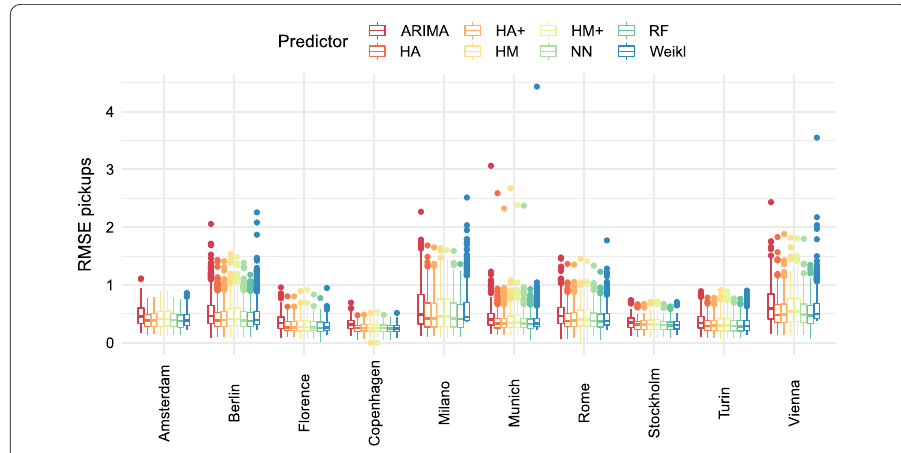
Figure 5 Box plot of RMSE for drop-offs in the 10 cities (1 hour time window)